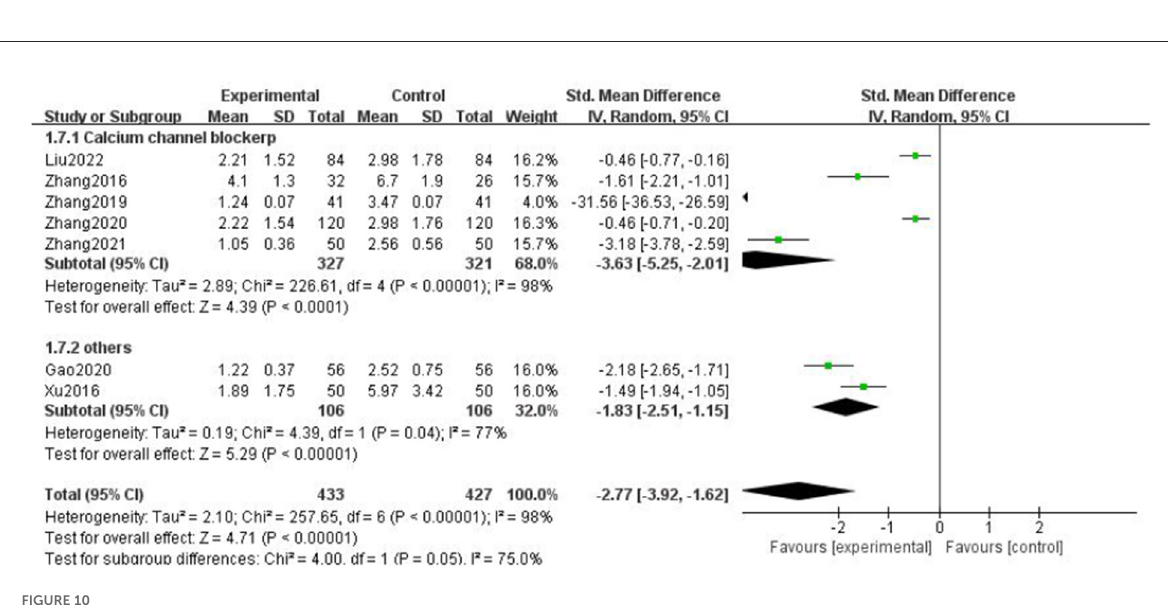
FIGURE10 Forest chart of frequency divided into subgroups according to